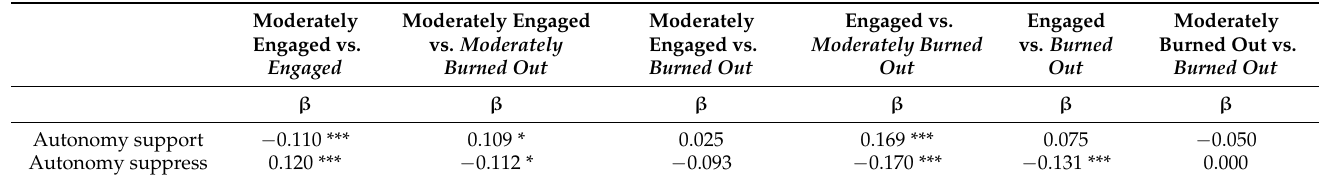
Table 4. Estimated Log odds for teaching methods predicting latent profile